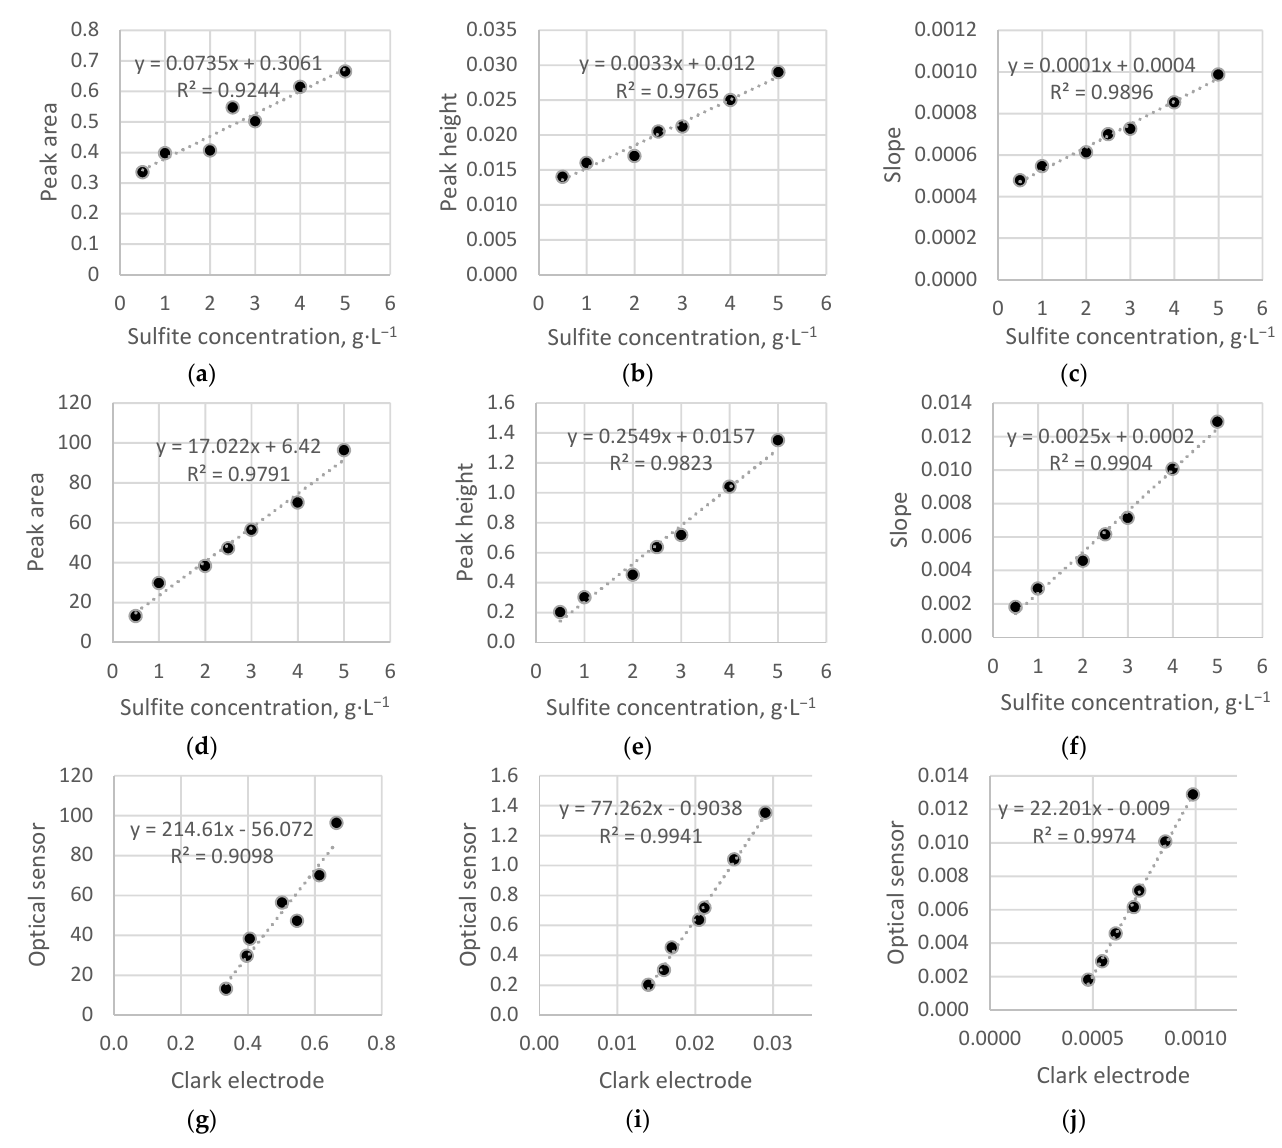
Figure 4. Calibration dependencies for different methods of the original data processing (calculated areas, heights, and slopes): ( a – c )—Clark electrode; ( d – f )—optical sensor. Readings of the optical sensor vs. Clark electrode: ( g )—peak area; ( i )—peak height; ( j )—slope.